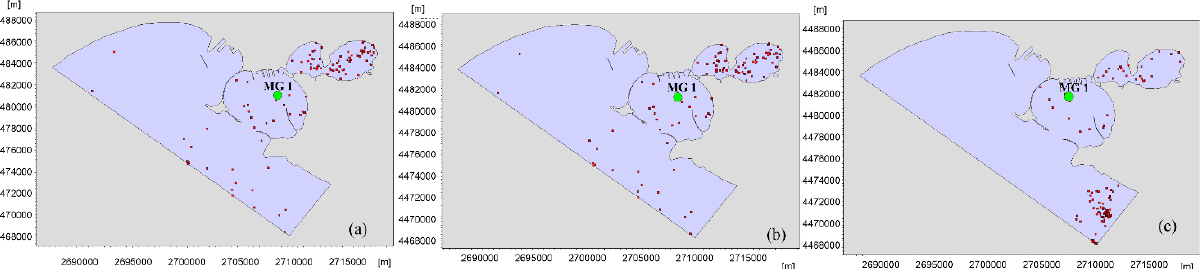
Figure 11. Percentage PT1 (MG1) — the cloud of particles: ( a ) 30 days after release; ( b ) 60 days after release; ( c ) 90 days after release at bottom layer.